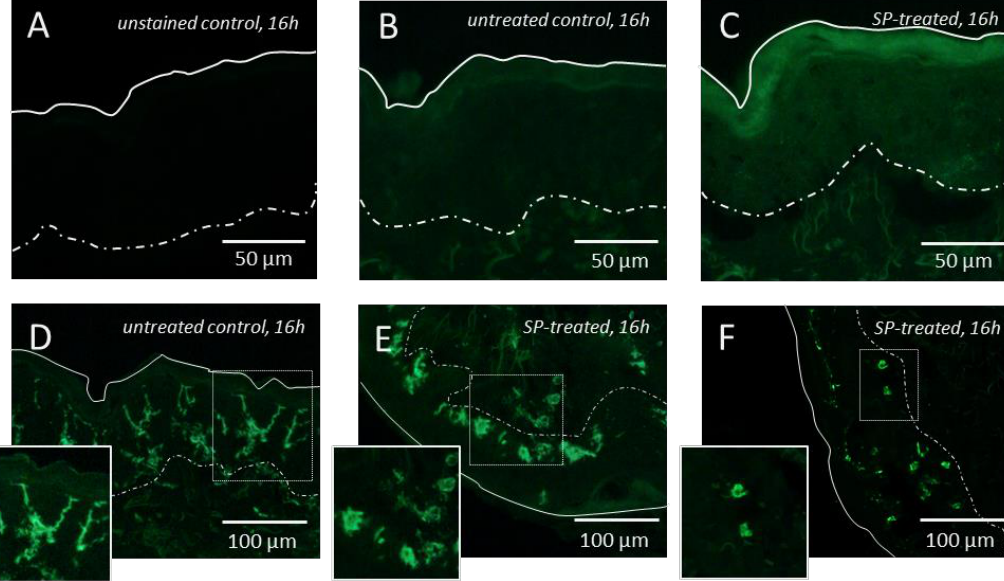
Figure 2. PAR2 expression and Langerhans cell activation in SP-treated skin. Representative images of sections stained for Protease activated receptor 2 (PAR2) compared to ( A ) the unstained control ( B ) show the presence of a PAR 2 signal in the upper part of the epidermis ( C ) and indicate an enhanced presence in SP-treated skin 16 h after pretreatment. ( D – F ) Representative images of sections stained for Cluster of Differentiation 1a (CD1a) show a loss of dendricity of CD1a+ epidermal Langerhans cells in SP-treated skin (representative images from n = 3 donors).